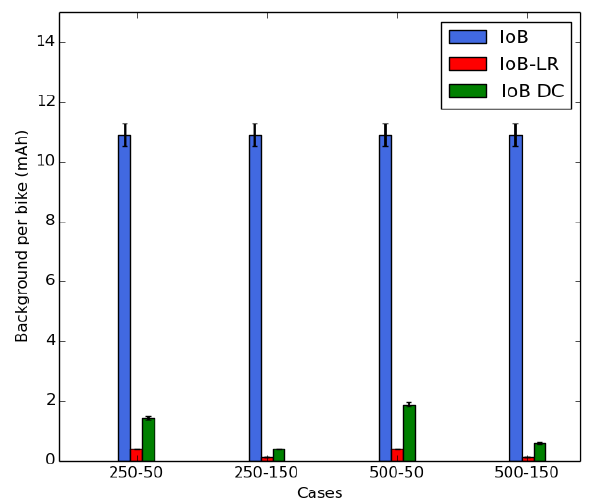
Figure 21. Average consumption background per